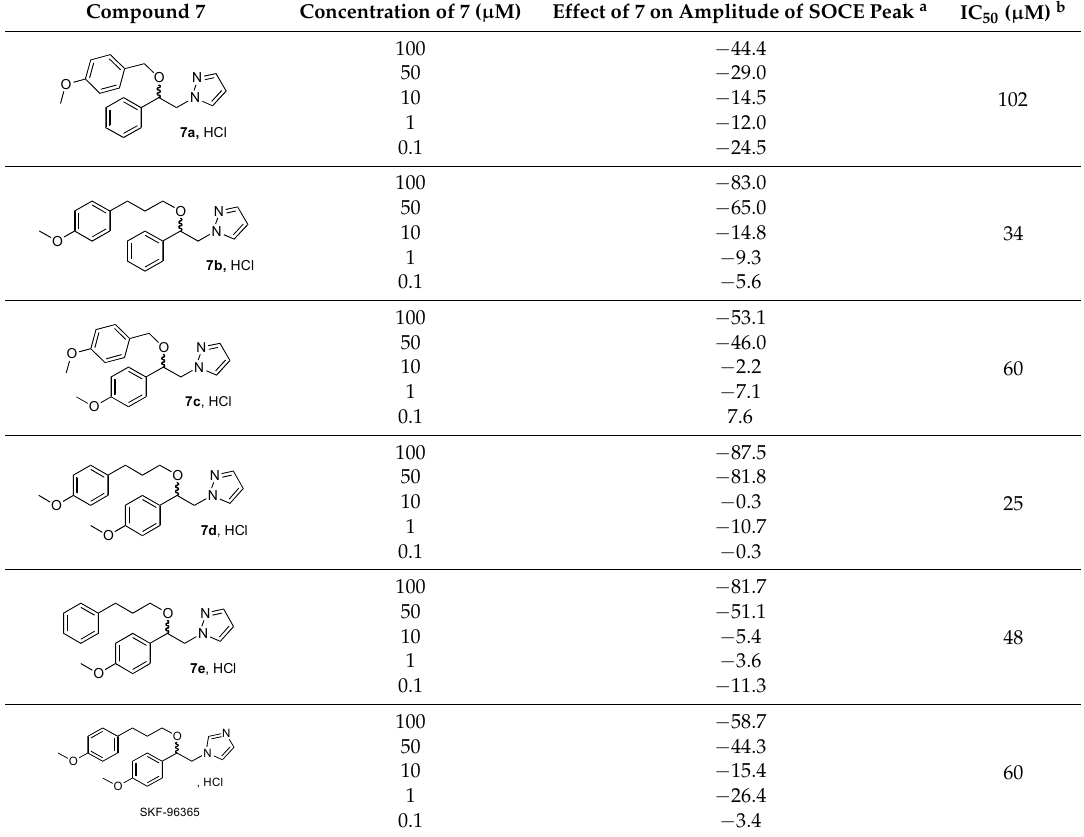
Table 4. Results for effects of ( ± )-(1 R , 1 S ) 1-[ β -(phenylalkoxy)-phenethyl]-1 H -pyrazolium hydrochloride 7a – e on store-operated Ca 2+ entry with PLP-B lymphocyte. Store-operated Ca 2+ Table 4. Results for effects of (±)-(1 R , 1 S ) 1-[ β -(phenylalkoxy)-phenethyl]-1 H -pyrazolium Table 4. Results for effects of (±)-(1 R , 1 S ) 1-[ β -(phenylalkoxy)-phenethyl]-1 H -pyrazolium Table 4. Results for effects of (±)-(1 R , 1 S ) 1-[ β -(phenylalkoxy)-phenethyl]-1 H -pyrazolium hydrochloride 7a – e on store-operated Ca 2+ entry with PLP-B lymphocyte. Store-operated Ca 2+ entry entry was induced by depletion of Endoplasmic Reticulum Ca 2+ stores (ER Ca 2+ stores) with Table 4. Results for effects of (±)-(1 R , 1 S ) 1-[ β -(phenylalkoxy)-phenethyl]-1 H -pyrazolium hydrochloride 7a – e on store-operated Ca 2+ entry with PLP-B lymphocyte. Store-operated Ca 2+ entry Table 4. Results for effects of (±)-(1 R , 1 S ) 1-[ β -(phenylalkoxy)-phenethyl]-1 H -pyrazolium hydrochloride 7a – e on store-operated Ca 2+ entry with PLP-B lymphocyte. Store-operated Ca 2+ entry was induced by depletion of Endoplasmic Reticulum Ca 2+ stores (ER Ca 2+ stores) with thapsigargin Table 4. Results for effects of (±)-(1 R , 1 S ) 1-[ β -(phenylalkoxy)-phenethyl]-1 H -pyrazolium hydrochloride 7a – e on store-operated Ca 2+ entry with PLP-B lymphocyte. Store-operated Ca 2+ entry thapsigargin (Tg) in a Ca 2+ -free medium and measured following the addition of 1.8 mM CaCl 2 was induced by depletion of Endoplasmic Reticulum Ca 2+ stores (ER Ca 2+ stores) with thapsigargin hydrochloride 7a – e on store-operated Ca 2+ entry with PLP-B lymphocyte. Store-operated Ca 2+ entry was induced by depletion of Endoplasmic Reticulum Ca 2+ stores (ER Ca 2+ stores) with thapsigargin (Tg) in a Ca 2+ -free medium and measured following the addition of 1.8 mM CaCl 2 in the extracellular hydrochloride 7a – e on store-operated Ca 2+ entry with PLP-B lymphocyte. Store-operated Ca 2+ entry was induced by depletion of Endoplasmic Reticulum Ca 2+ stores (ER Ca 2+ stores) with thapsigargin in the extracellular medium. (Tg) in a Ca 2+ -free medium and measured following the addition of 1.8 mM CaCl 2 in the extracellular was induced by depletion of Endoplasmic Reticulum Ca 2+ stores (ER Ca 2+ stores) with thapsigargin (Tg) in a Ca 2+ -free medium and measured following the addition of 1.8 mM CaCl 2 in the extracellular medium. was induced by depletion of Endoplasmic Reticulum Ca 2+ stores (ER Ca 2+ stores) with thapsigargin (Tg) in a Ca 2+ -free medium and measured following the addition of 1.8 mM CaCl 2 in the extracellular medium. (Tg) in a Ca 2+ -free medium and measured following the addition of 1.8 mM CaCl 2 in the extracellular medium. (Tg) in a Ca 2+ -free medium and measured following the addition of 1.8 mM CaCl 2 in the extracellular medium. medium. Compound 7 Compound 7 Compound 7